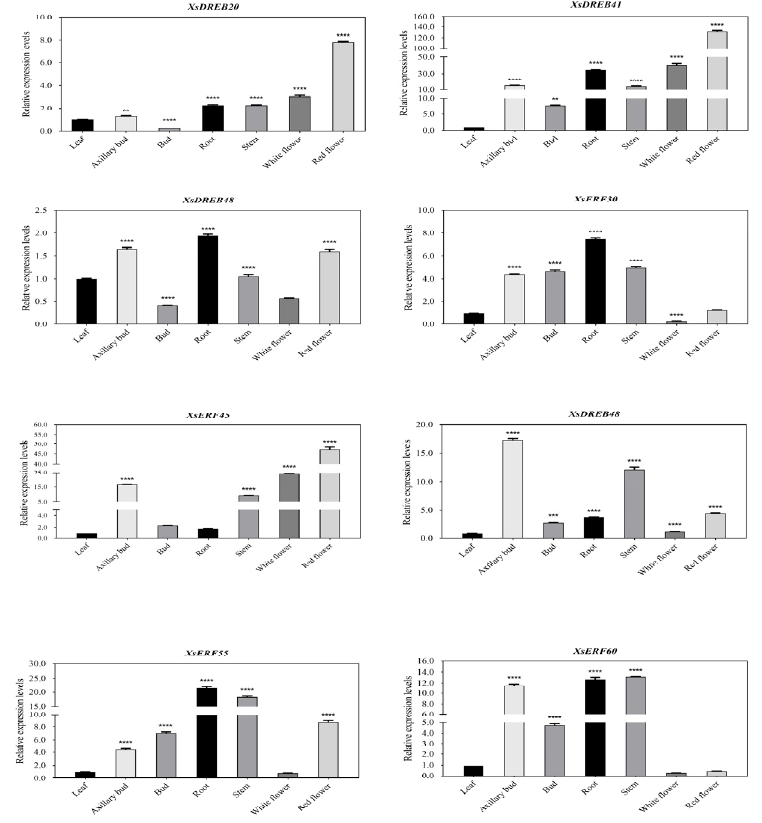
Figure 6. Real-time PCR analysis of eight XsAP2/ERF transcription factors in leaves, axillary buds, buds, stems, roots, safflower, and white flowers of mature plants. The X -axis is different tissues. The Y -axis represents the relative expression levels of transcription factors. The data represent the mean ± SE of three dependent replicates. A p -value less than 0.01 (**), 0.001 (***), or 0.0001 (****) indicates statistical significance.